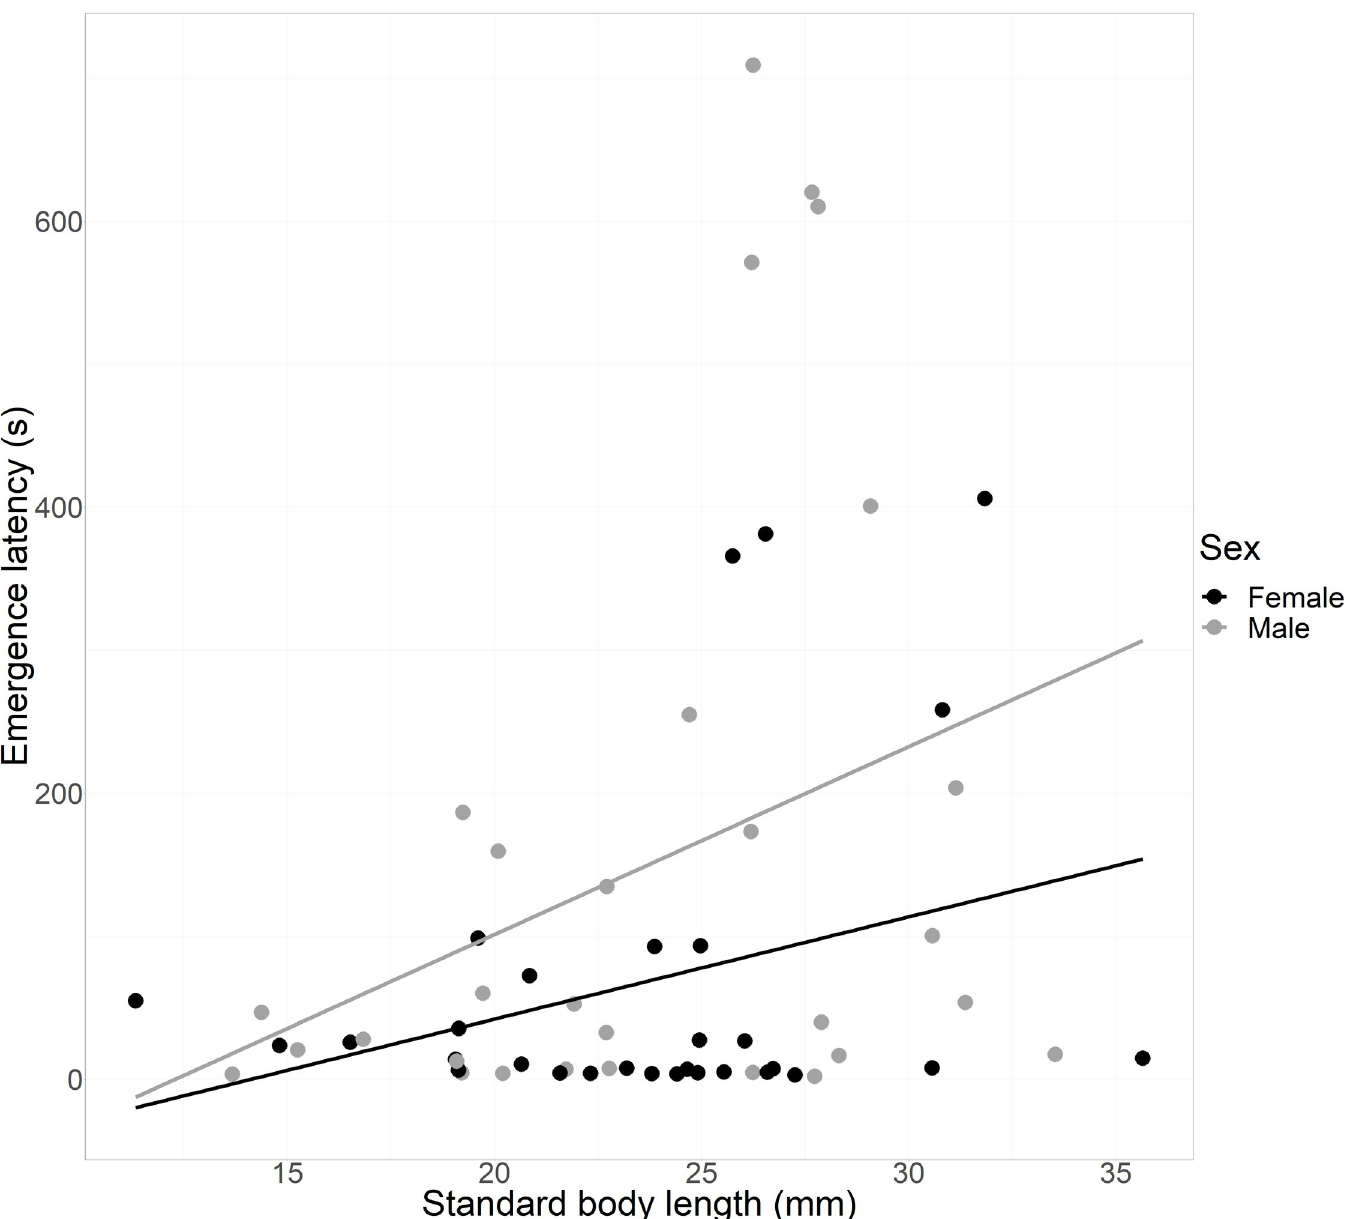
Fig 2. Emergence latency. Females were faster than males to leave the refuge. Tendency lines are for visualisation of tendencies and derive from linear models for females (y = -100.97 + 7.14 x, r ^ 2 = 0.062) and males (y = -161.4 + 13.12 x, r ^ 2 = 0.07).